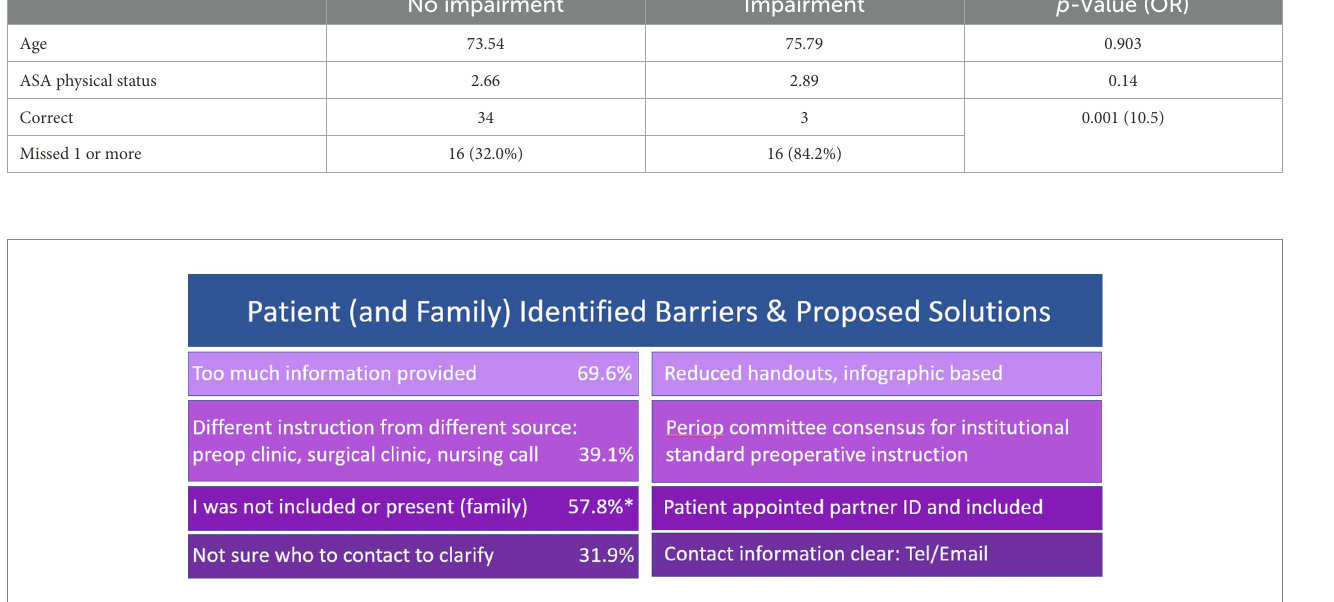
FIGURE 2 Identified barriers to correct execution of preoperative instructions with corresponding proposed team-based solutions. The frequency of each identified barrier among all patients is included. The frequency of reporting inclusion or presence of a family member as a barrier was only included for those with preoperative cognitive impairment.*